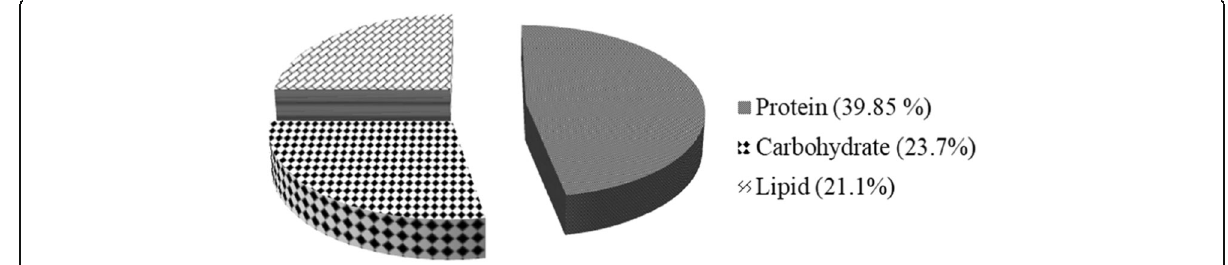
Fig. 7 The biochemical composition of Chlorella sp. MF.1 (as percentage of dry